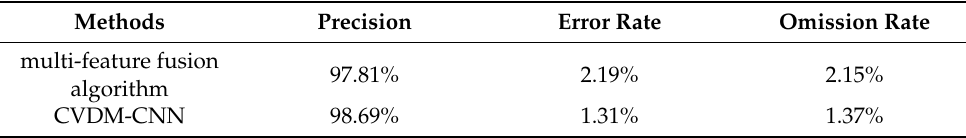
Table 3. Detection performance under good driving environment.